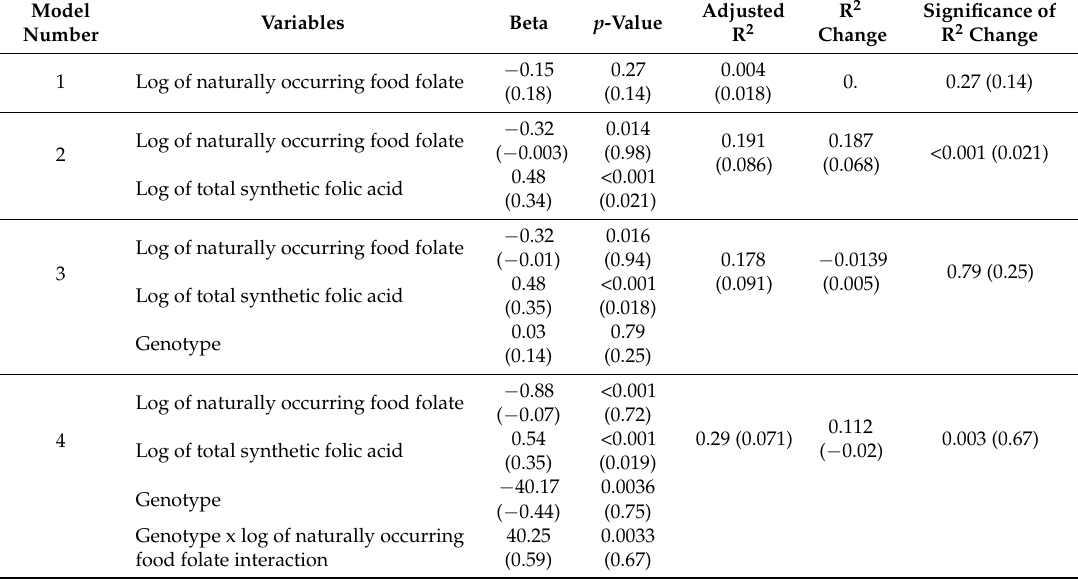
Table 6. Predictors of RBC folate in Caucasian females and males via hierarchical linear